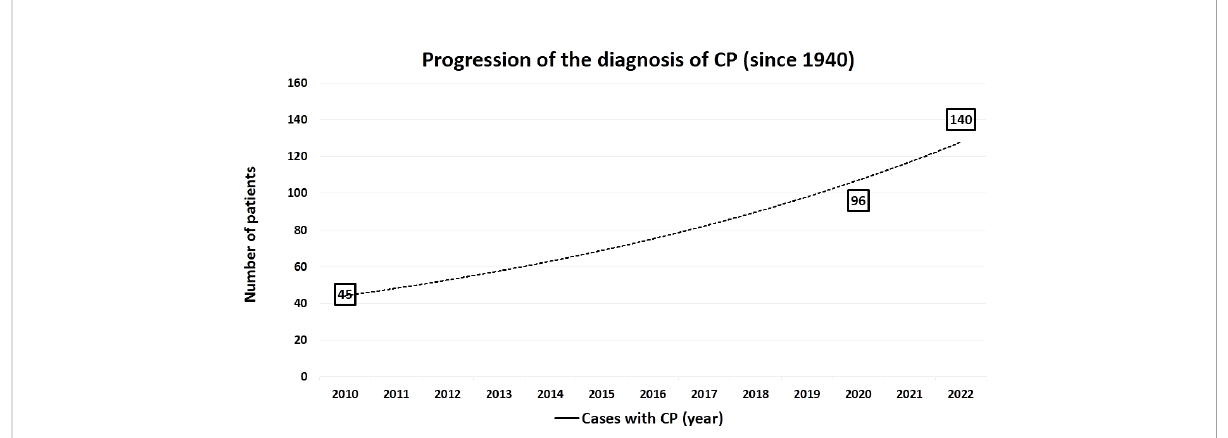
FIGURE 3 Increasing diagnosis of composite pheochromocytoma (CP) during last eight decades (1940-2022), including the three casesof the present study. CP, composite